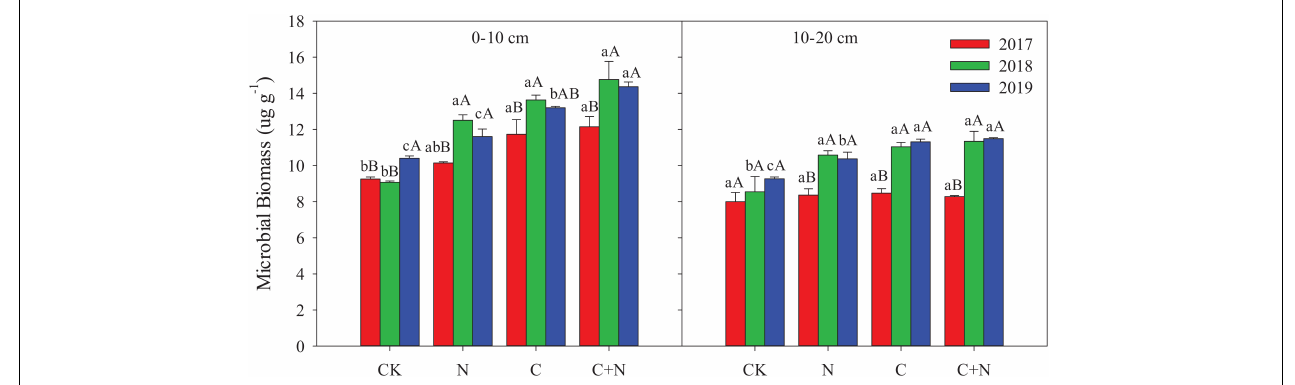
FIGURE 2 | Effects of different treatments on bacteria and fungi in 0–20 cm soil layers in 2017, 2018, and 2019. Error bars represent standard errors of the mean values, and different lowercase letters over the bars indicate differences among different treatments in the same year at P < 0.05. Different uppercase letters over the bars indicate differences among different years in the same treatment at P < 0.05.